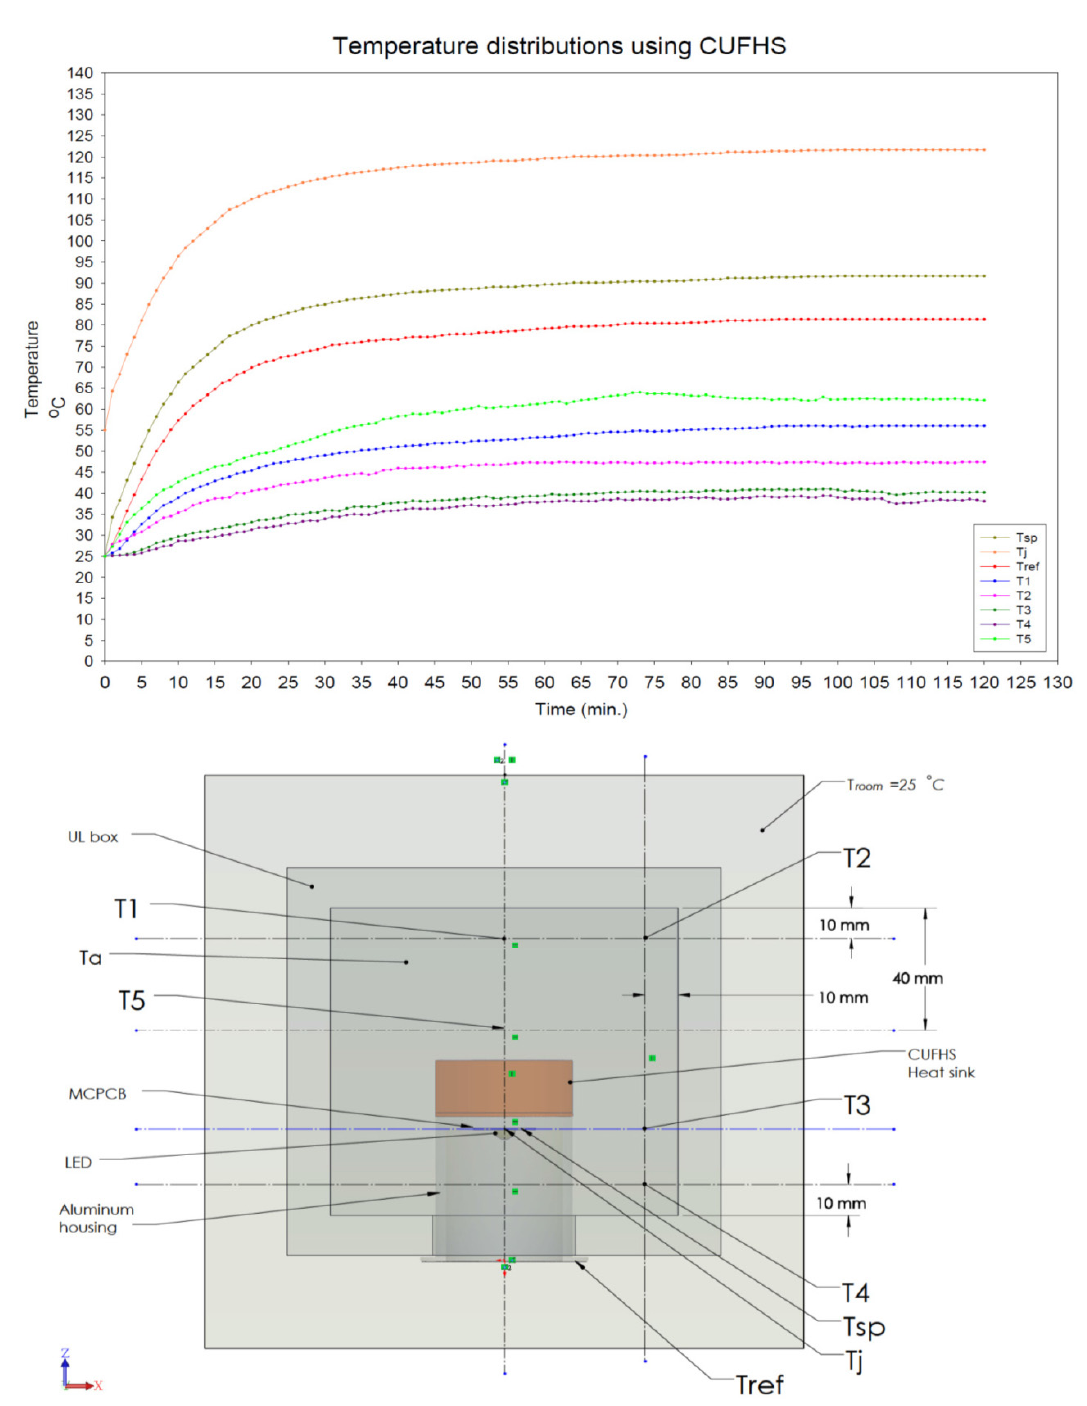
Figure 10. Chart of specified points of T sp , T j , T ref , T 1 , T 2 , T 3 , T 4 , and T 5 temperature distributions for the CUFHS mounted to the CLRDL after INST. Table 3. Temperature ( ◦ C) distribution of specified points for CUFHS mounted to CLRDL after INST in the